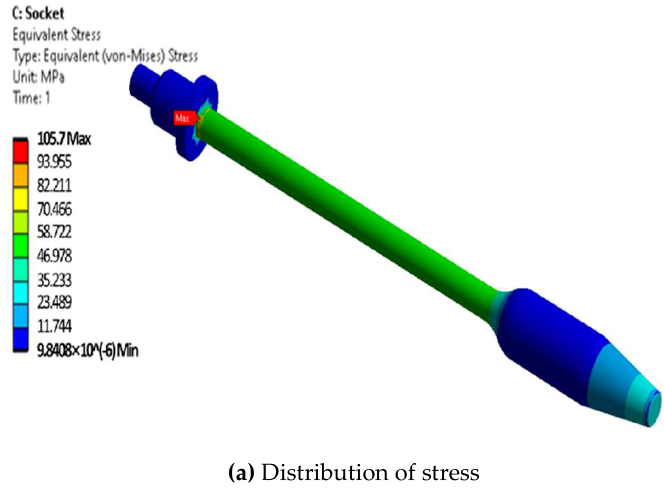
Figure 8. Analysis results for the cylinder shaft.